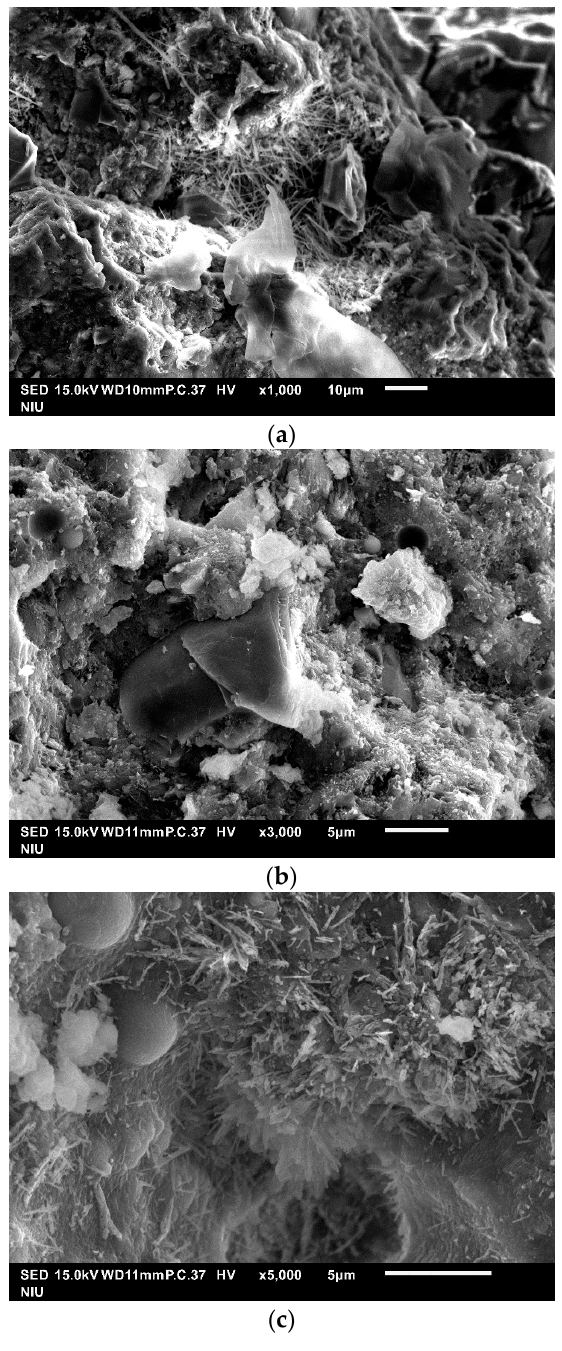
Figure 12. SEM images of UHPG pastes: ( a ) ×1000 magnification; ( b ) ×3000 magnification; ( c ) ×5000 magnification.